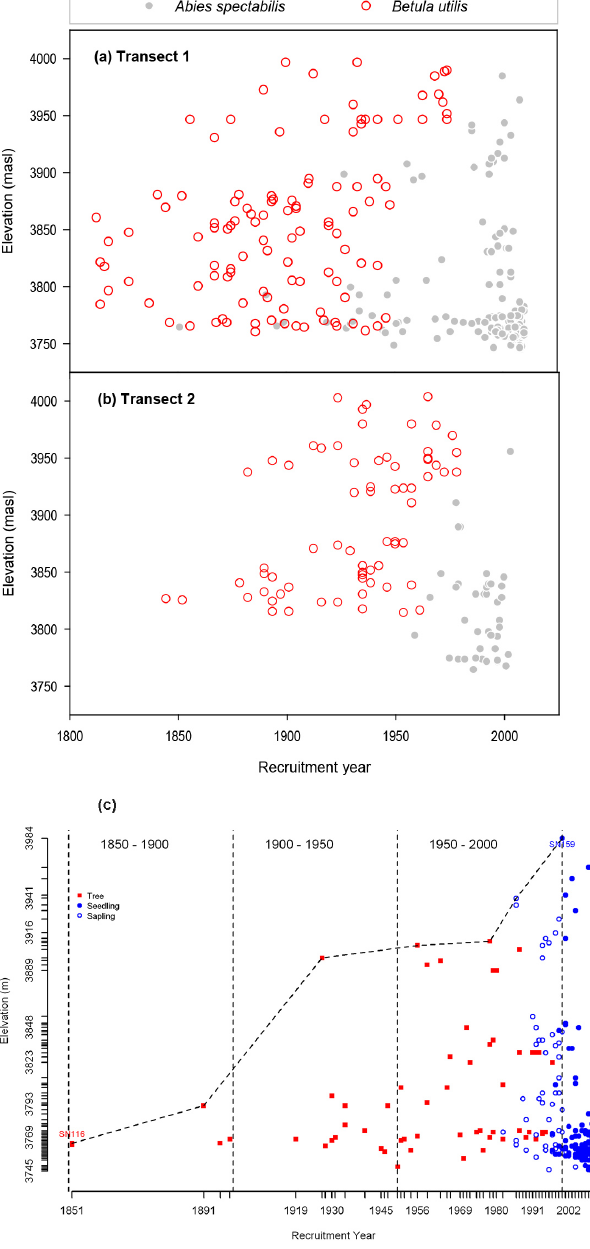
Figure 4. (a, b) Spatial and temporal variation in the recruitment of tree species in T1 and T2. (c) Temporal upward shifting of Abies spectabilis along an elevation gradient in the study